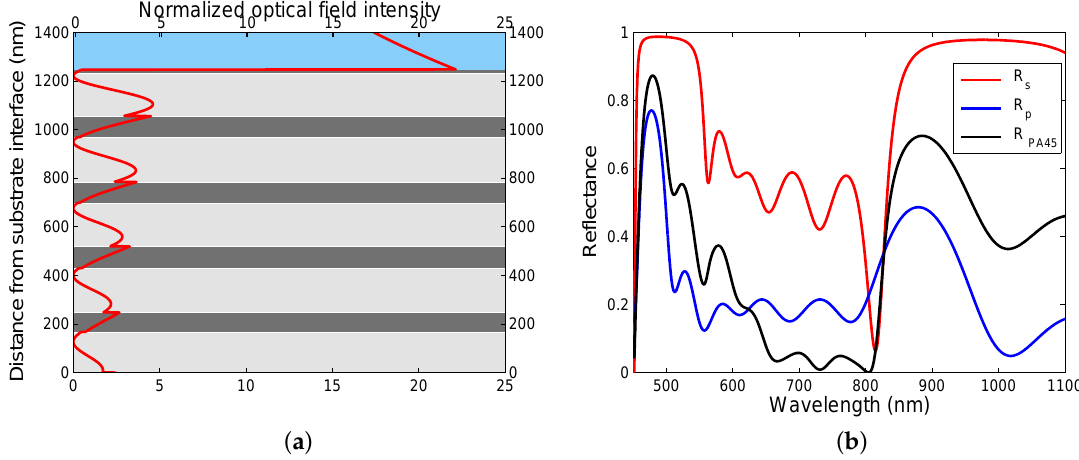
Figure 6. The normalized optical field intensity distribution in the MDS for an angle of incidence of θ = 41.9 ◦ and λ = 955.4 nm ( a ); Theoretical spectral reflectances R s ( λ ) , R p ( λ ) , and R PA45 ( λ ) for θ = 40.5 ◦ ( b ). TM wave and analyte is